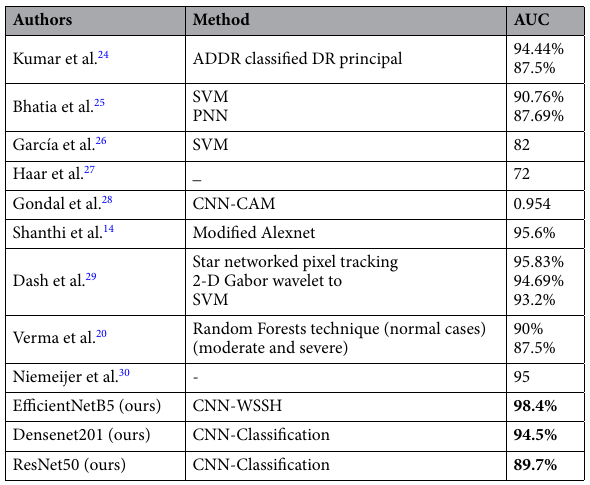
Table 3. Level performance comparison with different techniques for Lesion detection.